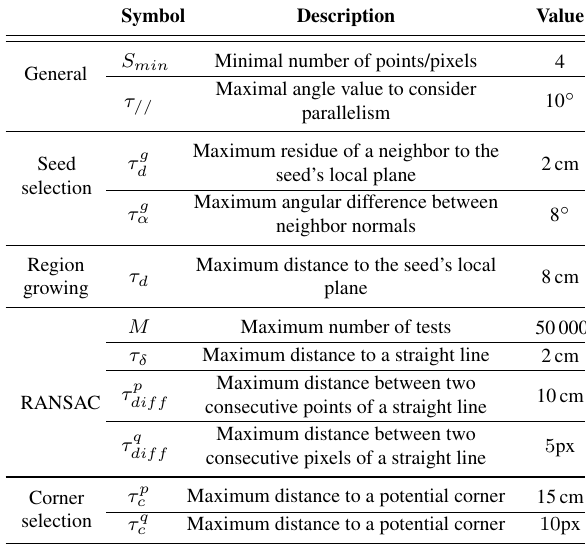
Table 1. Parameters of the proposed method